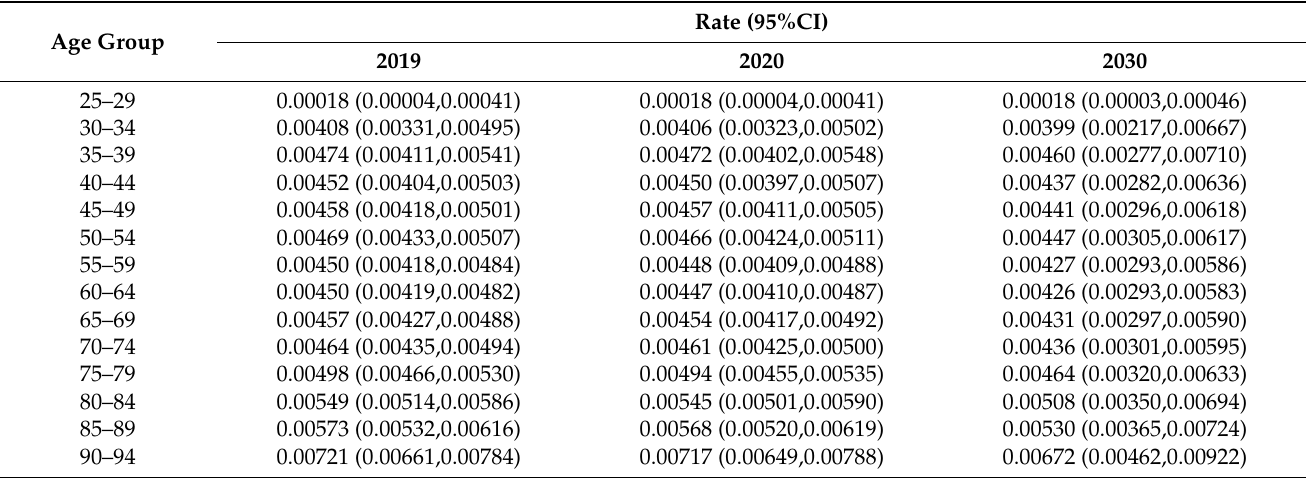
Table 2. Projected mortality rate and corresponding 95%CI for males in selected